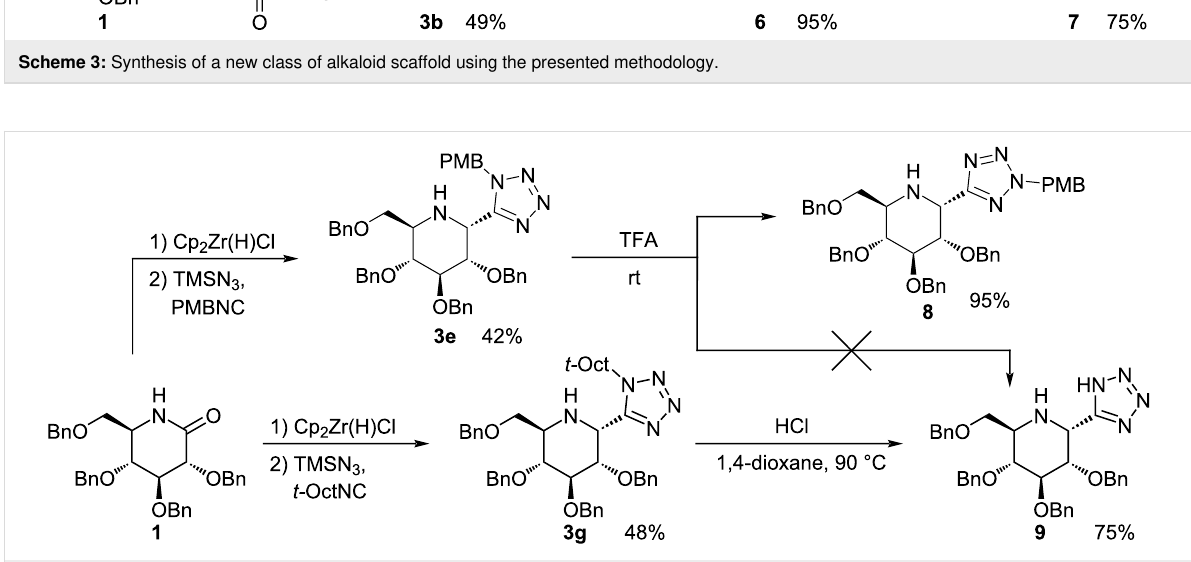
Scheme 4: Synthesis of a new, chiral 2-(tetrazol-5-yl)-iminosugar based potential organocatalyst.